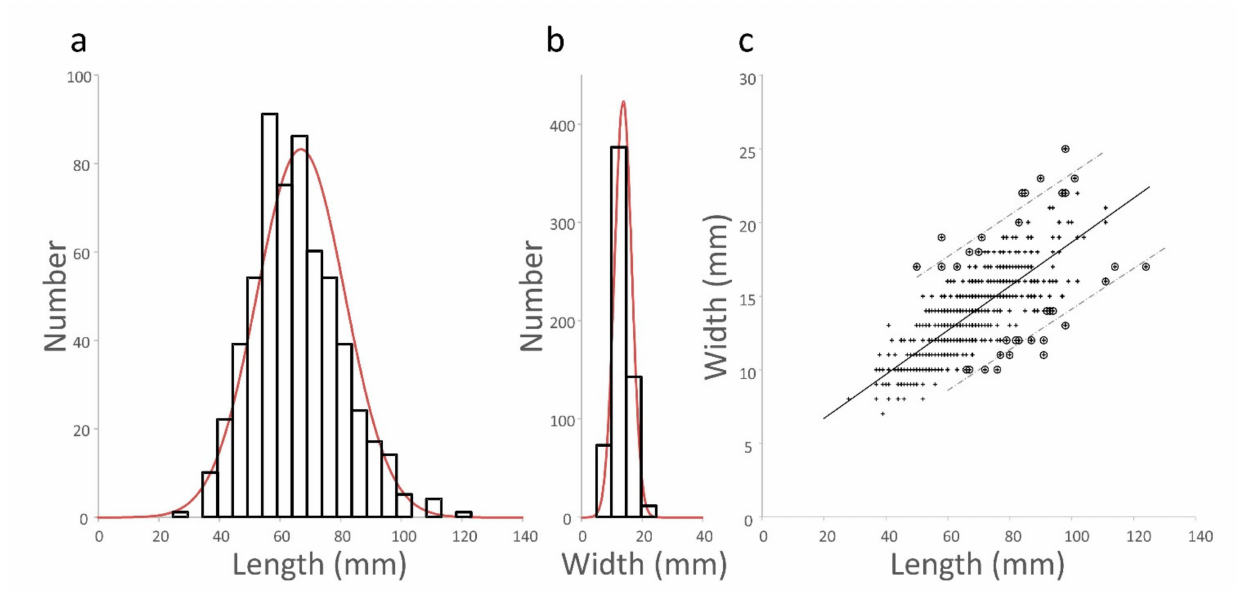
Figure 2. Pod length and width. Frequency distribution of ( a ) pod lengths and ( b ) pod widths. The red line in ( a , b ) is the expected normal distribution with the same mean and standard deviation. ( c ) Covariation of pod length and width. The crosses represent the individual length, width measurements (see Supplementary Table S1). The solid black line is the regression line for all data. The ringed data points are extreme values (see text) and the dashed lines are the regression lines for the upper and lower extremes respectively. The central solid regression line follows the relationship: W = (0.15 ± 0.005) L + (3.71 ±